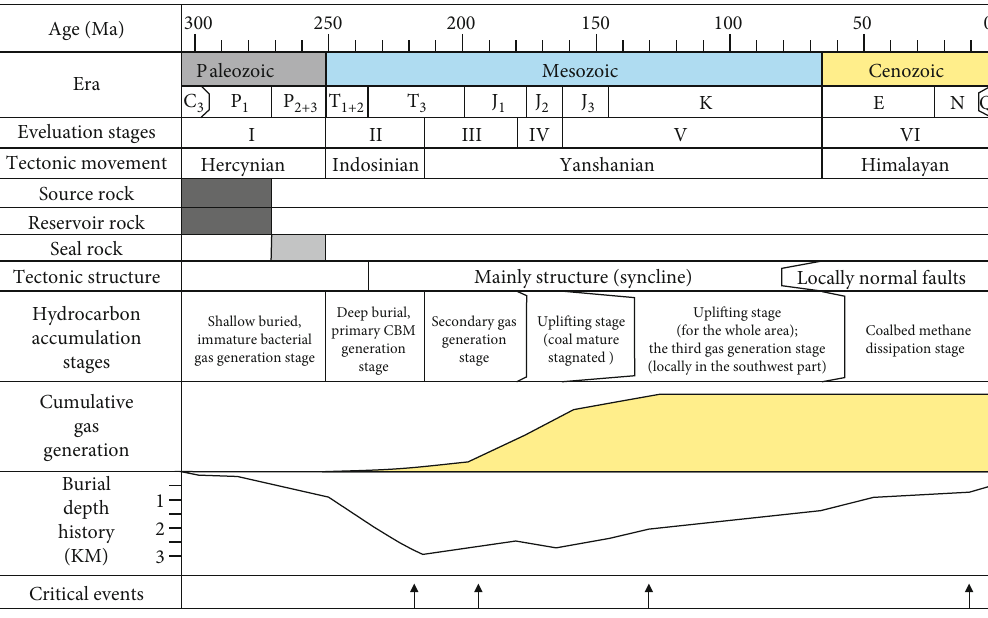
Figure 9: Extended essential element diagram showing the hydrocarbon system present in the study area with relation to tectonic activity and general tectonic behavior.